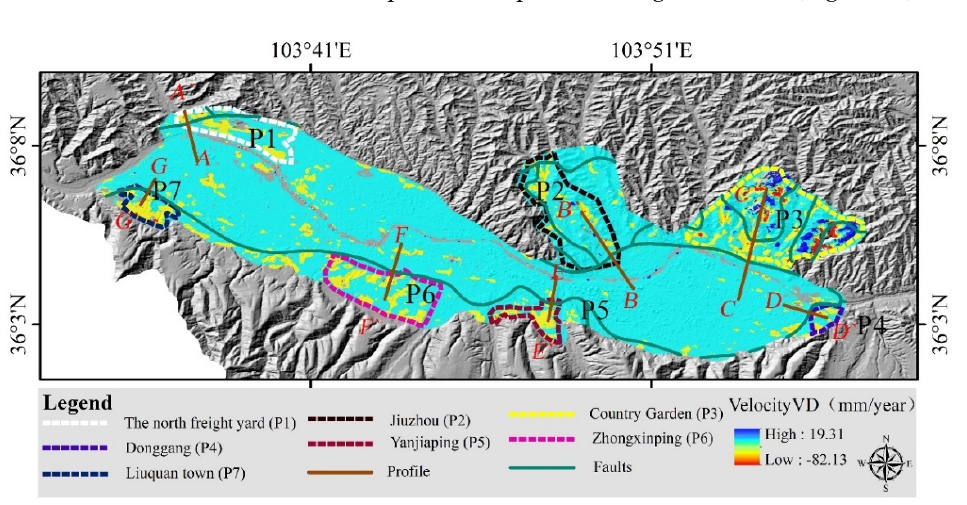
Figure 11. Distribution of the deformation rate and geological faults.